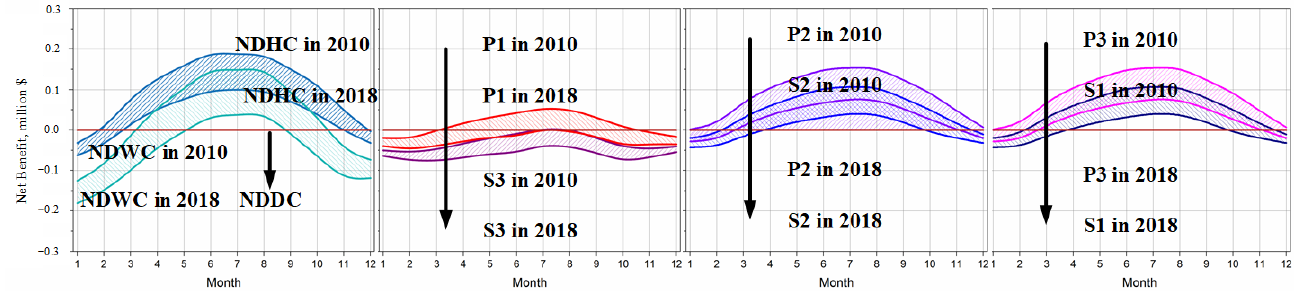
Figure 13. Net benefits of different cooling systems compared with